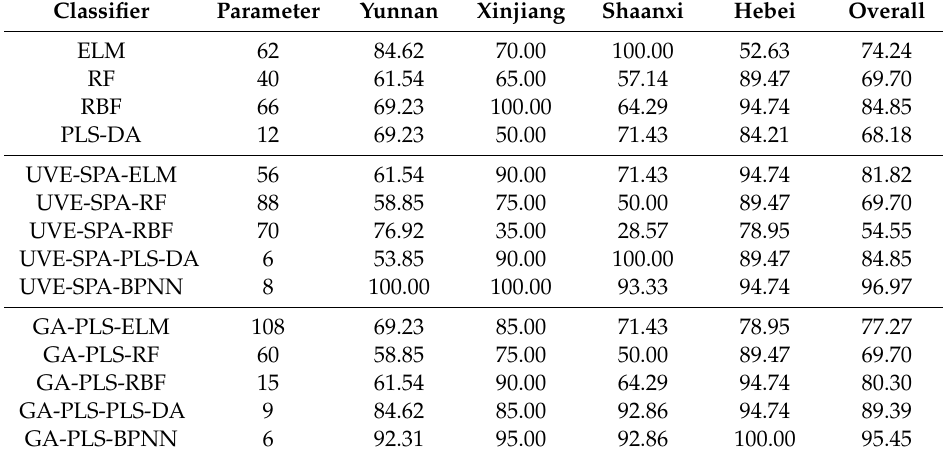
Table 1. Modeling performances to classify four geographic origins on test set built from the full spectral range and subsets of the selected variable using di ff erent classifiers. Classifier Parameter